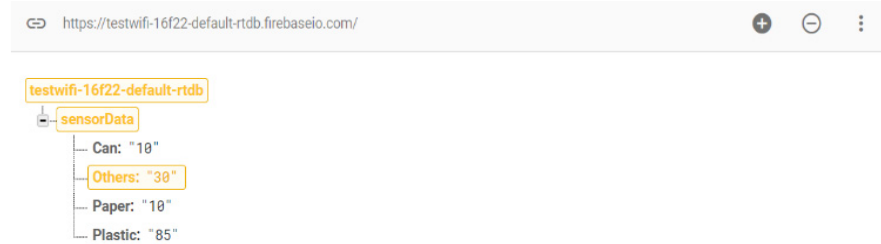
Figure 13. Capacity value in Firebase Database.